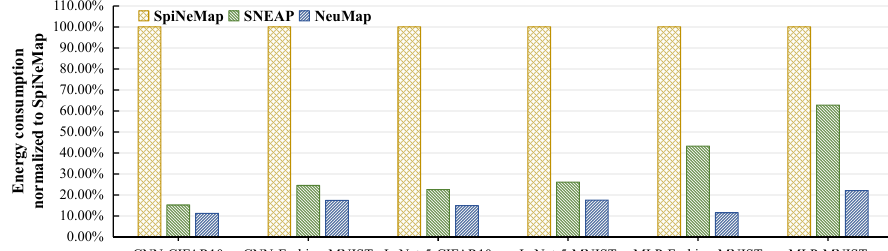
Figure 15. The energy consumption on NoC normalized to SpiNeMap.